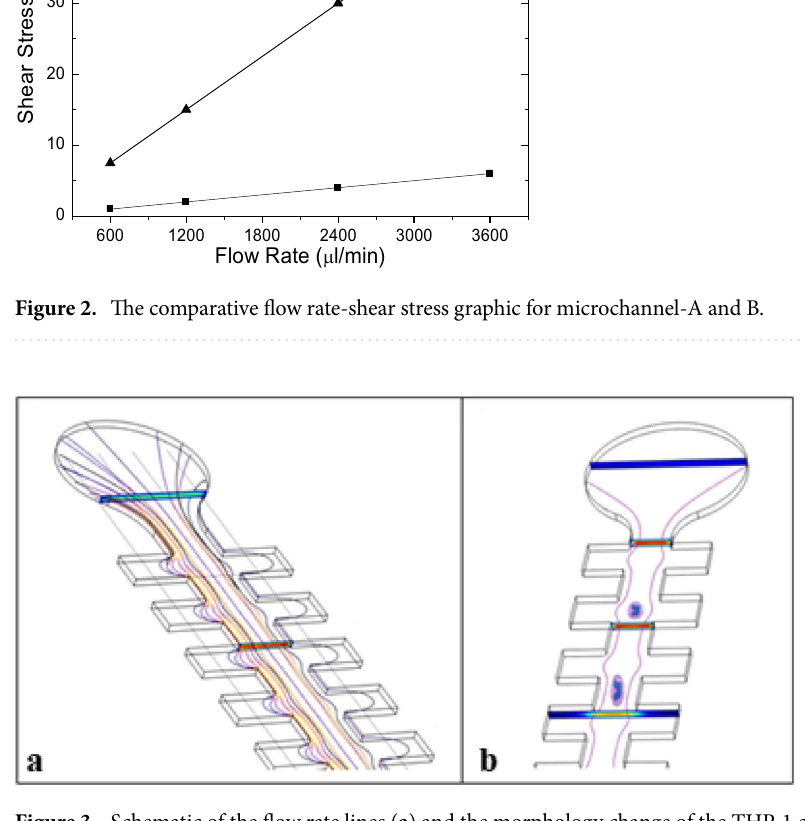
Figure 3. Schematic of the flow rate lines ( a ) and the morphology change of the THP-1 cells ( b ) inside the